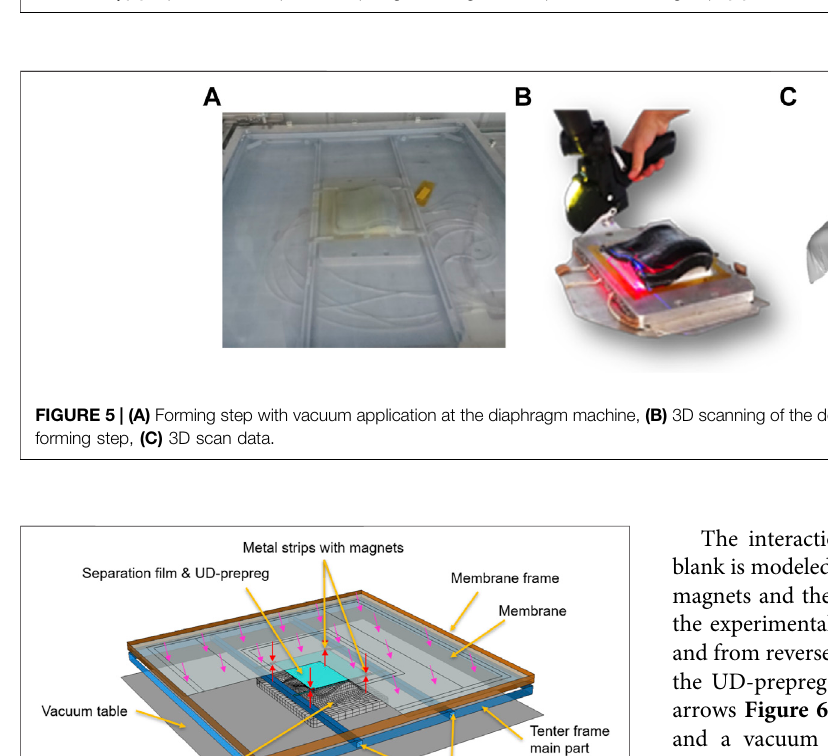
Frontiers in Materials |